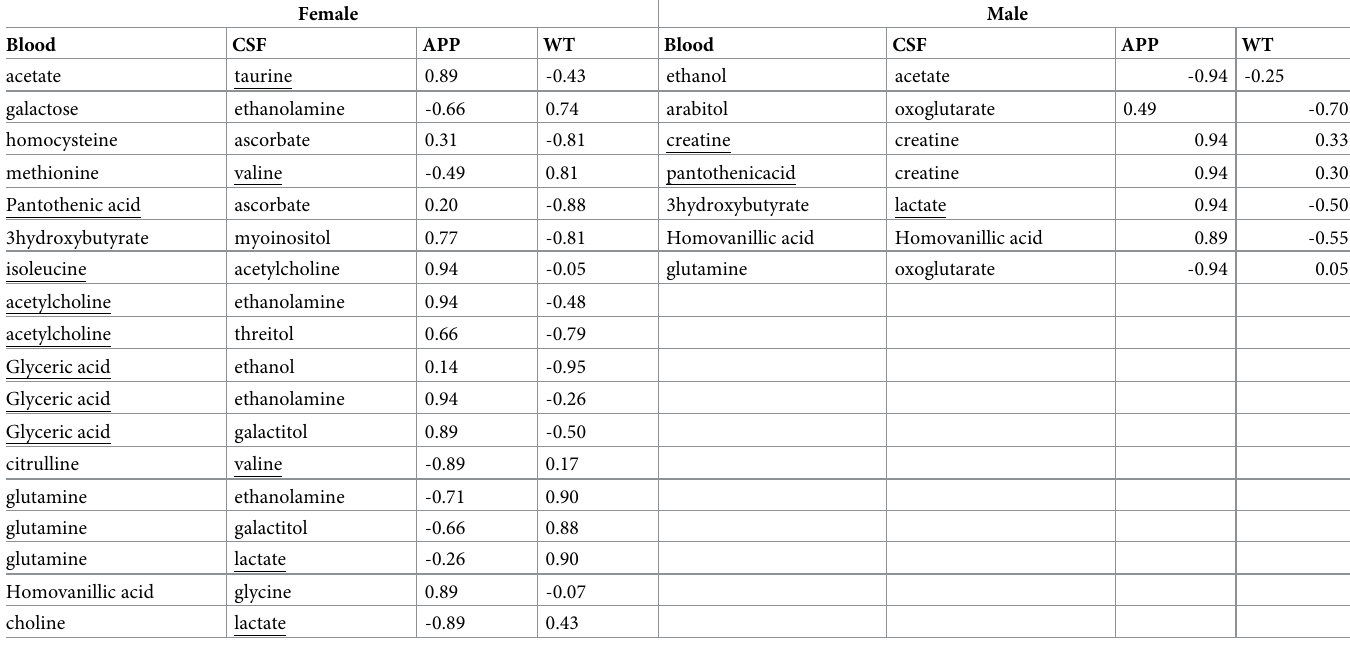
Table 1. Significantly different correlations between female and male APP/PS1 (APP for brevity) and WT